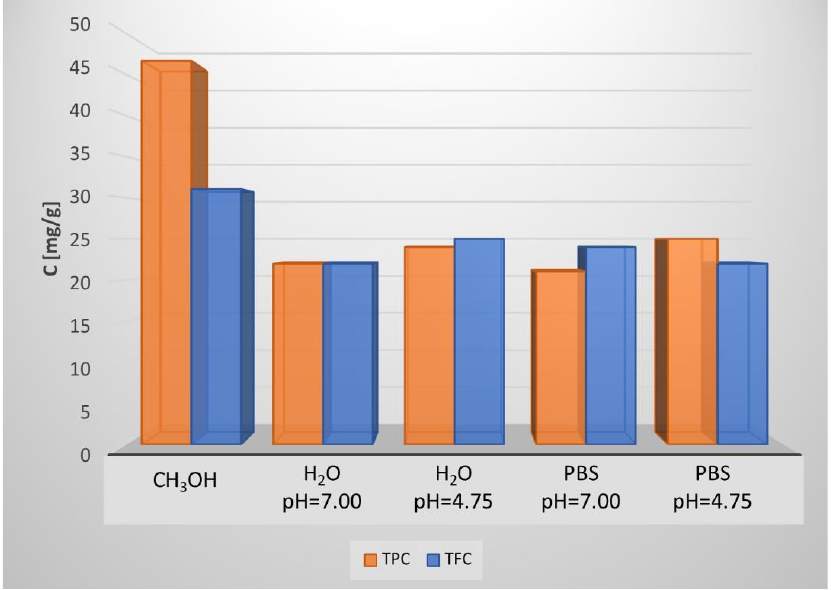
Figure 2. Total phenolic content (TPC) and total flavonoid content (TFC) vs. the type of solvent (a 1 h time of extraction).